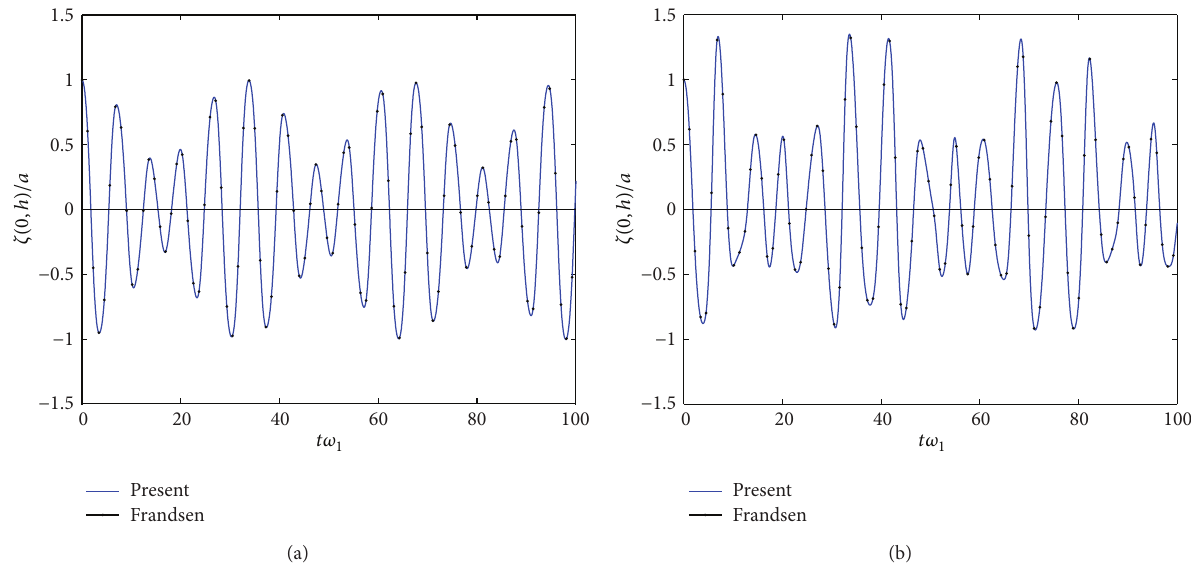
Figure 10: Free-surface elevation on the left wall in the stable region (test case 5) for Ω 1 = 0.55 , 𝑘 V = 0.5 : (a) 𝜀 = 0.0014 , and (b) 𝜀 = 0.288 .